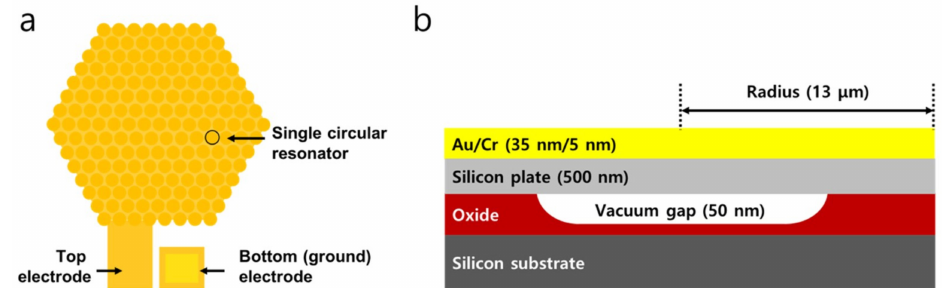
Figure 2. ( a ) Schematic diagram of a CMUT sensor composed of multiple circular resonators connected in parallel. For electrostatic actuation, DC and AC voltages are applied across the top and bottom electrodes. ( b ) Schematic diagram of a cross-section of a single circular